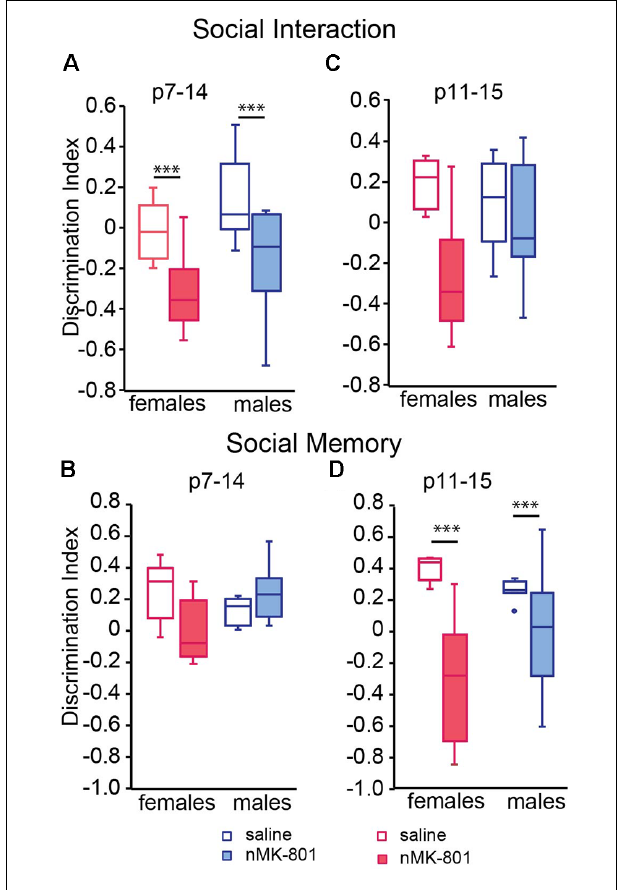
FIGURE 3 | Effects of neonatal treatment with MK-801 at p7–14 (A,B) ( n = 15) and p11–15 (C,D) ( n = 15) compared to the respective saline-treated mice ( n = 13 for each saline-treated group) on sociability and social memory. Open bars represent saline-treated mice, while colored bars represent the nMK-801-treated mice. (A) In the sociability test, there was a significant effect of nMK-801 (p7–14) treatment ( F (1,26) = 15.264, p = 0.001), but not effect of sex ( F (1,26) = 3.809, p = 0.061) or sex ∗ treatment interaction ( F (1,26) = 0.013, p = 0.909). (B) In the social memory test, there was a significant effect of sex ∗ treatment interaction ( F (1,26) = 10.303, p = 0.003), but no effect of sex (